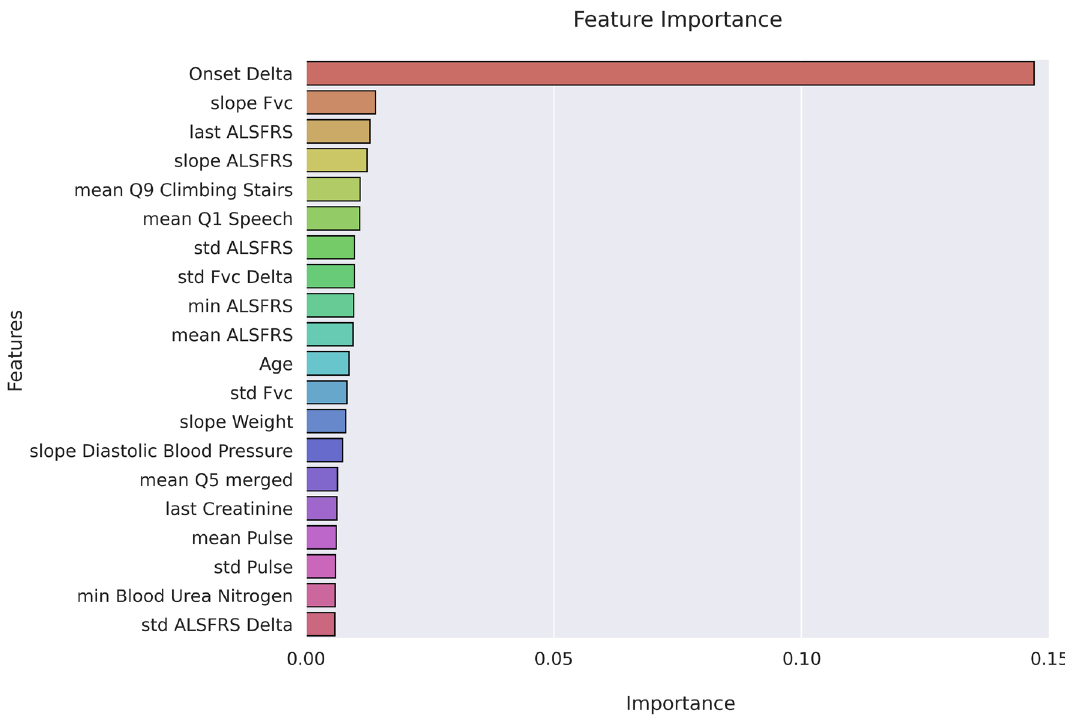
Figure 3. Feature importance. Top 20 most important features ranked by Random Forest via cross-validation on the training set, using the Gini